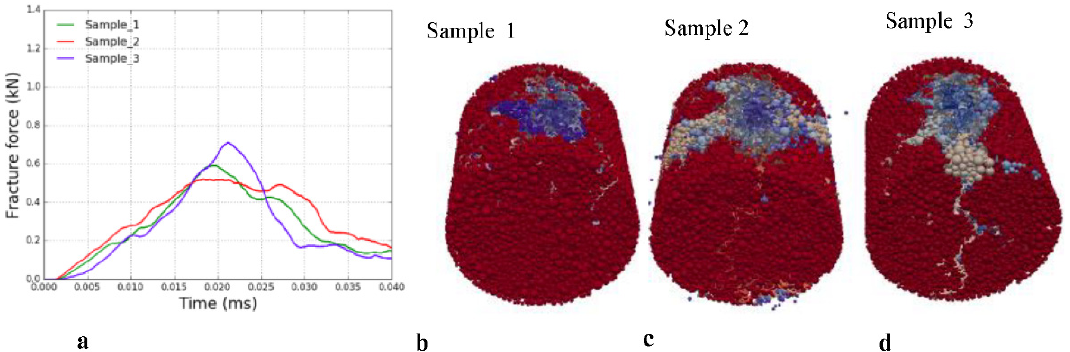
Figure 13. ( a ) Force-time histories of three rock specimens at 300-crack level and ( b – d ) their respective post-process analyses showing the fracture pattern.